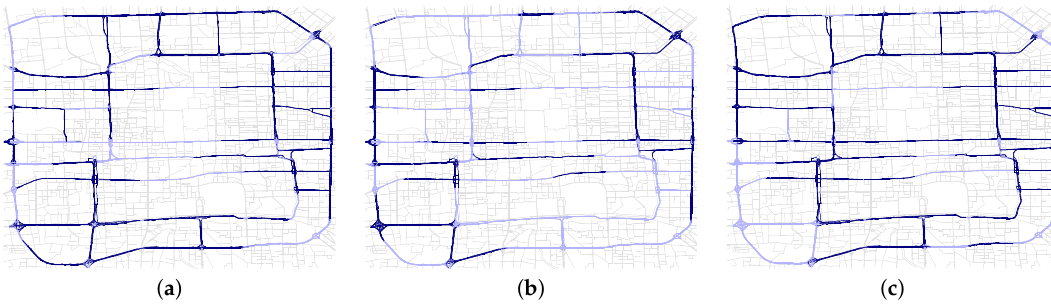
Figure 13. Single-Evolving Anomaly within the third ring road in different time. Segments in dark blue are anomalies. ( a ) 8:00–9:00; ( b ) 13:00–14:00; ( c ) 18:00–19:00.